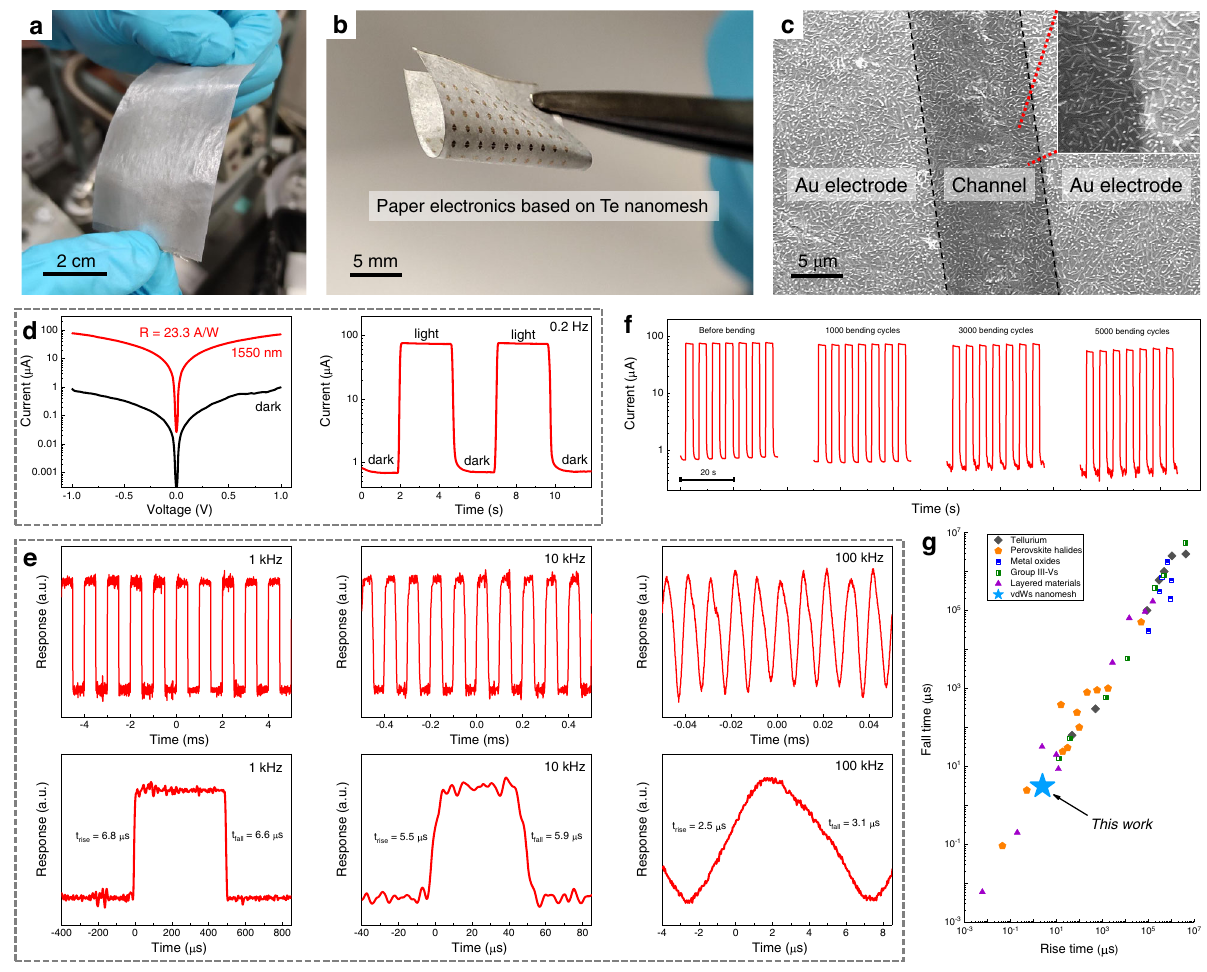
Fig. 6 | Paper-basednanomesh infraredphotodetectors.a Photographof wafer- scale Te nanomesh grown on paper substrates. b Photograph and c SEM image of TenanomeshPDbasedonpapersubstrates.Reddashedlinesindicatetheenlarged position. d Photodetection performance of the paper-based Te nanomesh PD measured at 1550nm irradiation with an incident power density of 4mW/cm 2 . e Photoresponse with different chopped frequencies from 1kHz to 100kHz.